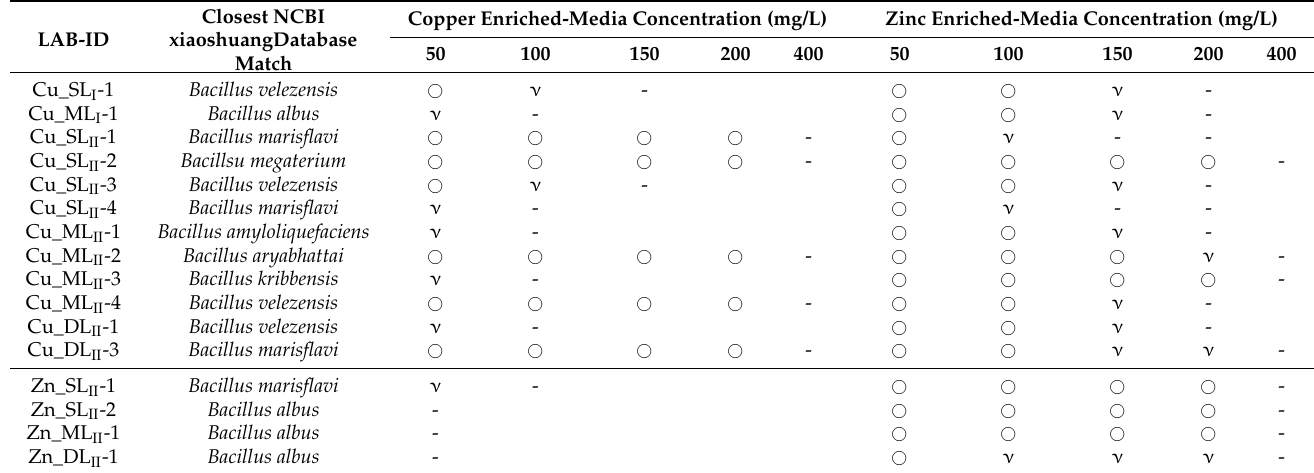
Table 4. Taxonomic identification of bacteria species with similarities on the NCBI Blast database. The tolerance index level of bacteria strains in copper/zinc enriched-media with different concentrations is presented.